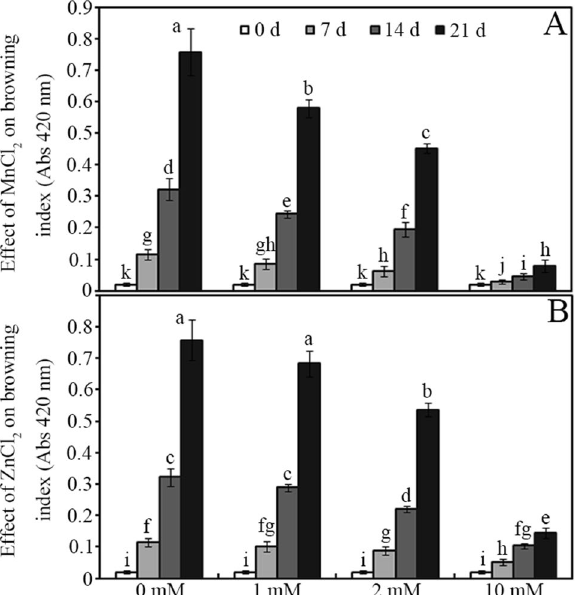
Figure 1. Effects of different concentrations (0, 1, 2 and 10 mM) of MnCl 2 ( A ) and ZnCl 2 ( B ) on enzymatic browning of soya bean sprouts after storage for 0, 7, 14 and 21 days. Bars represent the standard deviation of the mean ( n = 3); means associated with the same letter are not significantly different ( P <